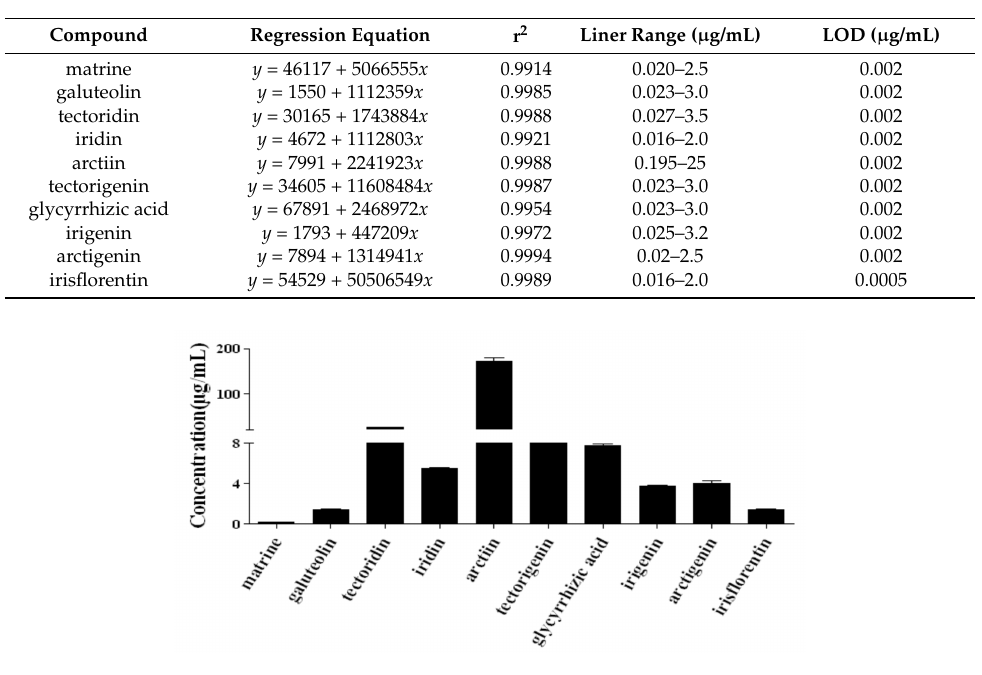
Figure 2. Extracted ion chromatograms of the ( I ) reference standards and ( II ) SJLYKL sample: ( a ) matrine; ( b ) galuteolin; ( c ) tectoridin; ( d ) iridin; ( e ) arctiin; ( f ) tectorigenin; ( g ) glycyrrhizic acid; ( h ) irigenin; ( i ) arctigenin; ( j ) irisflorentin. Table 2. Regression equation, correlation coefficients, and LOD of the ten compounds.